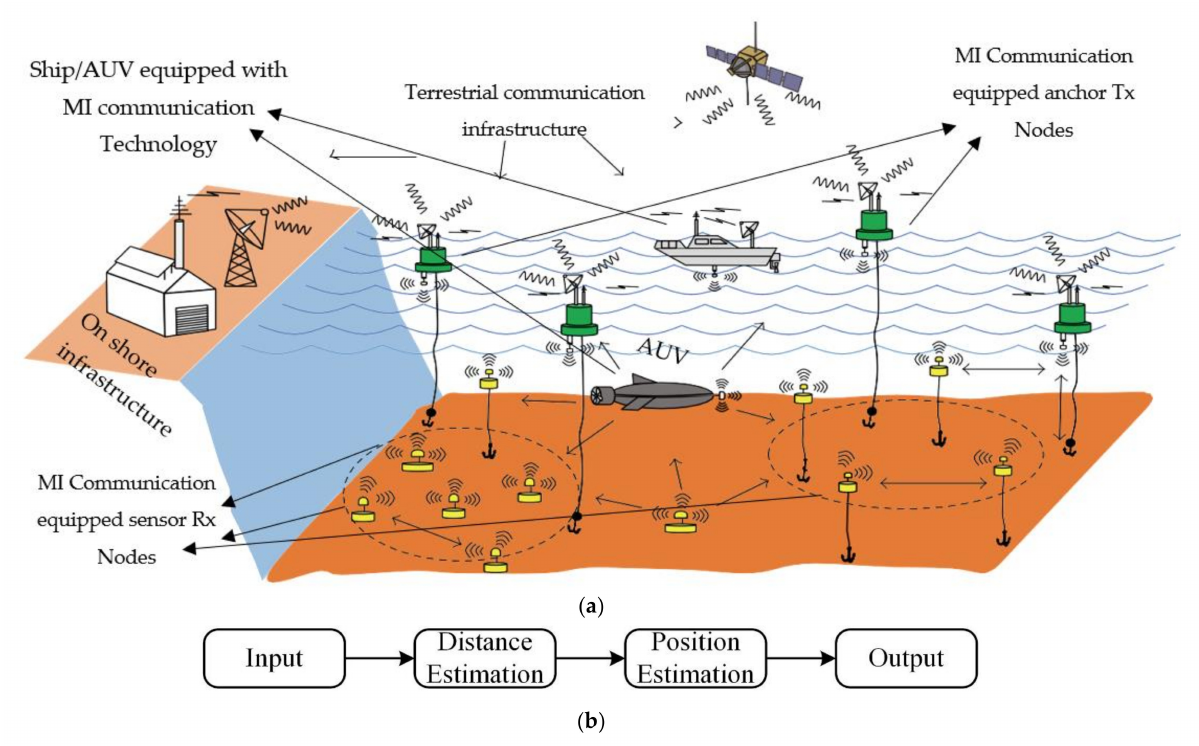
Figure 1. ( a ) Showing a basic scenario of MI-UWSNs. ( b ) Localization process flow